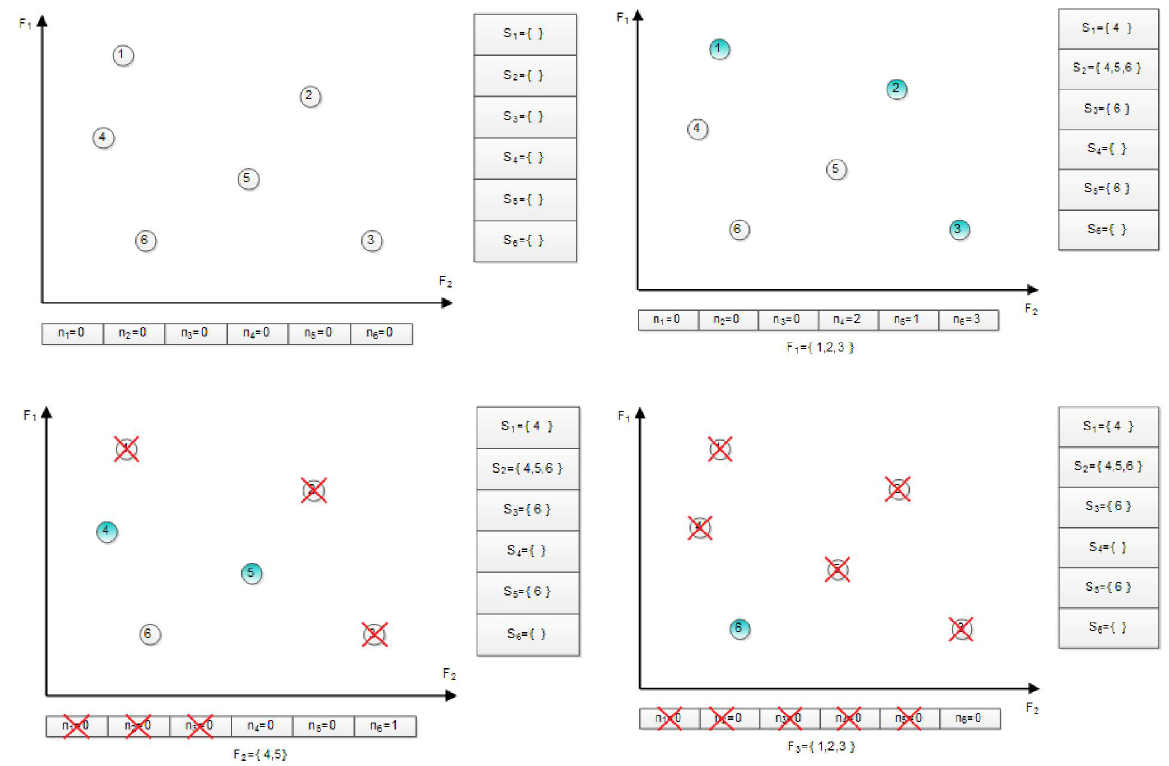
Fig. 1. Stages of determining Pareto answers with various ranks in the six permutation